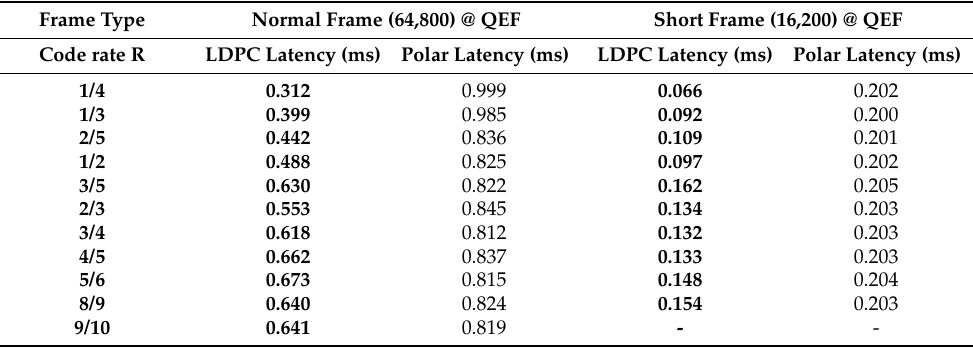
Figure 9. BER versus E b / N 0 for LDPC & optimized polar codes for short frame with N = 16,200 and different code rates R in DVB-S2. Table 3. Encoding average latency comparisons between LDPC code and optimized Polar code for normal frame and short frame. (bold cells represent the best